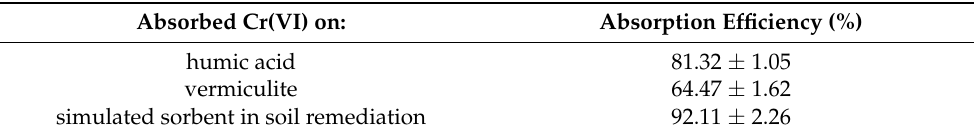
Table 1. Absorption efficiencies of Cr(VI) onto sorbents.